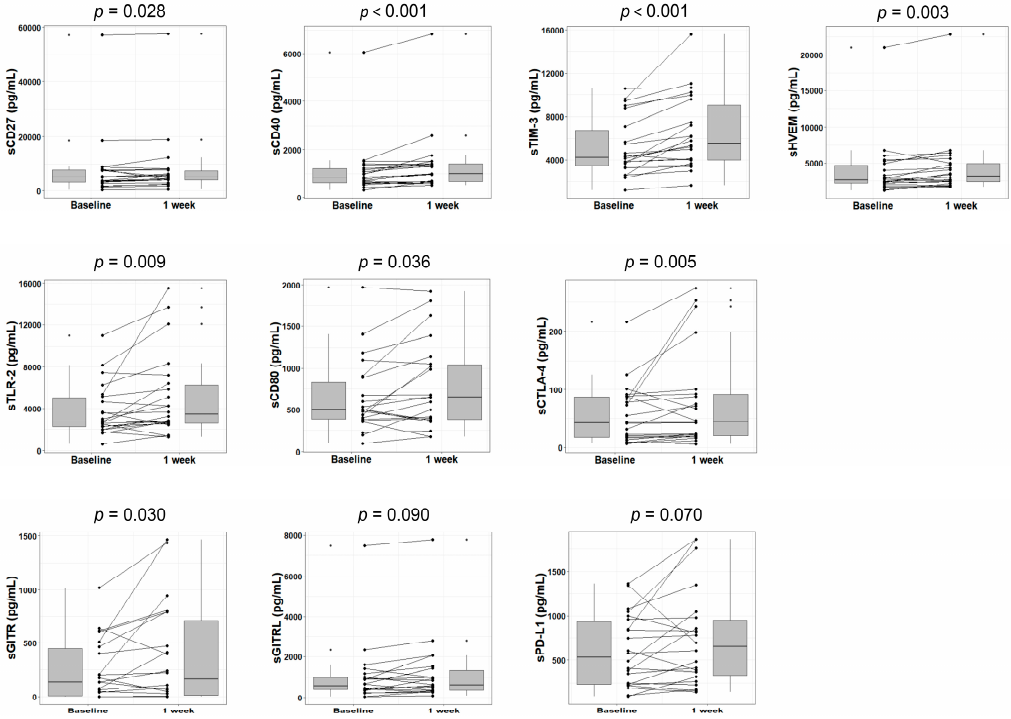
Figure 3. Changes in soluble immune checkpoint protein levels in plasma after 1 week of TACE treatment. Box plots display the sCD27, sCD40, sTIM-3, sHVEM, sTLR-2, sCD80, sCTLA-4, sGITR, sGITRL, and sPD-L1 levels in HCC patients at baseline and Week 1 of treatment. The vertical lengths of the boxes indicate the interquartile ranges and the lines in the boxes suggest the median values, while the error bars show the minimum and maximum values (range). The Wilcoxon signed-rank test was used. TACE, transarterial chemoembolization; sTLR-2, soluble Toll-like receptor 2; sCTLA-4, soluble cytotoxic T-lymphocyte antigen 4; sGITR, soluble glucocorticoid-induced tumor necrosis factor receptor; sGITRL, soluble glucocorticoid-induced TNFR-related ligand; sPD-L1, soluble p rogrammed death-ligand 1 .